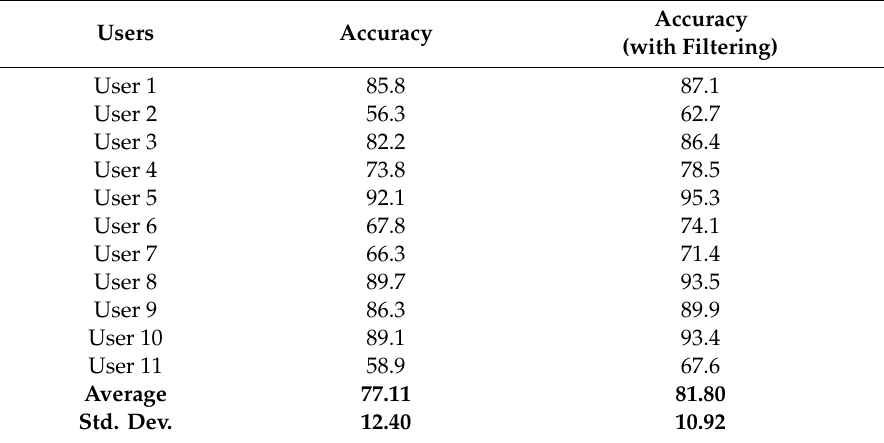
Table 7. One-subject-out prediction accuracies for the LUMED dataset.